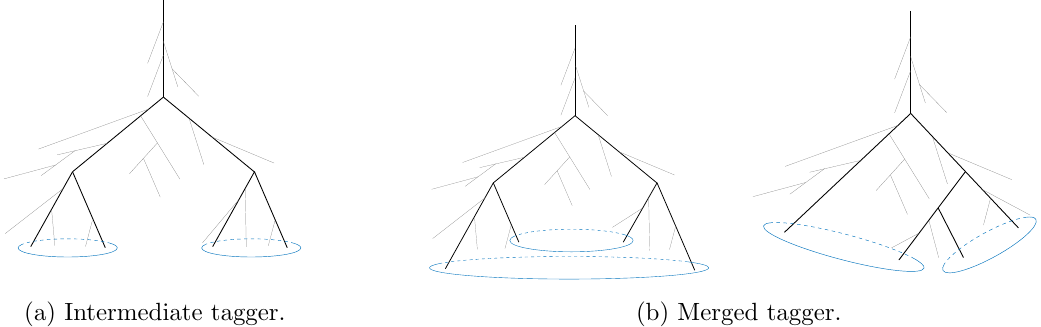
Figure 5. Left: hard splitting tree (solid black lines) and assignment of subjets to W candidates (blue ellipses) which is assumed by the intermediate tagger. Right: the two possible hard splitting trees allowed by the merged tagger. Grey lines show soft splittings. Also shown are example assignments of subjet pairs to W candidates. These pairings are chosen to minimize the mass di(cid:11)erence between the two W candidates in the